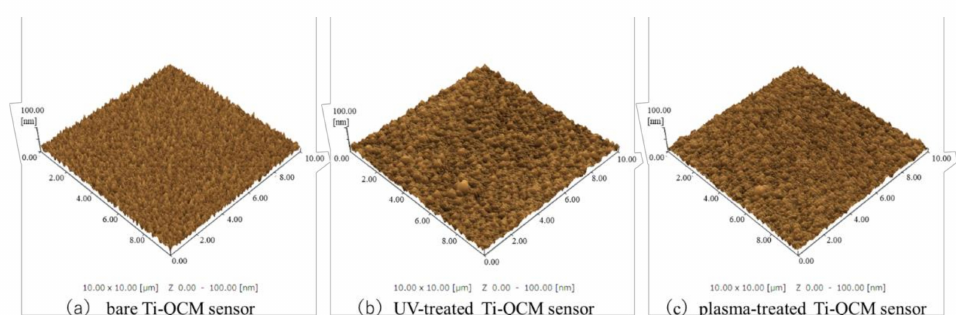
Figure 2. SPM images of ( a ) bare, ( b ) UV-treated, and ( c ) plasma-treated Ti-QCM sensors.